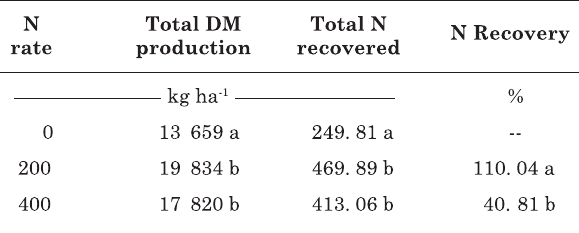
Table 1. Forage yield, N recovery and total N recovered by Brachiaria plantaginea under N